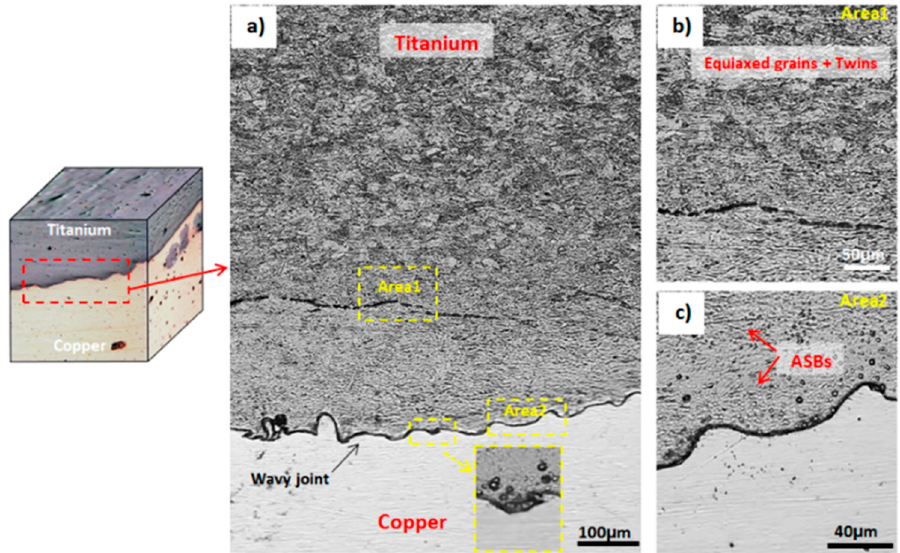
Figure 2. Optical microscopy images showing ( a ) titanium and copper near weld interface, ( b ) titanium microstructure with equiaxed grains and twins, ( c ) adiabatic shear bands (ASBs) and the wavy interface formed between Ti-Cu bimetal joint.